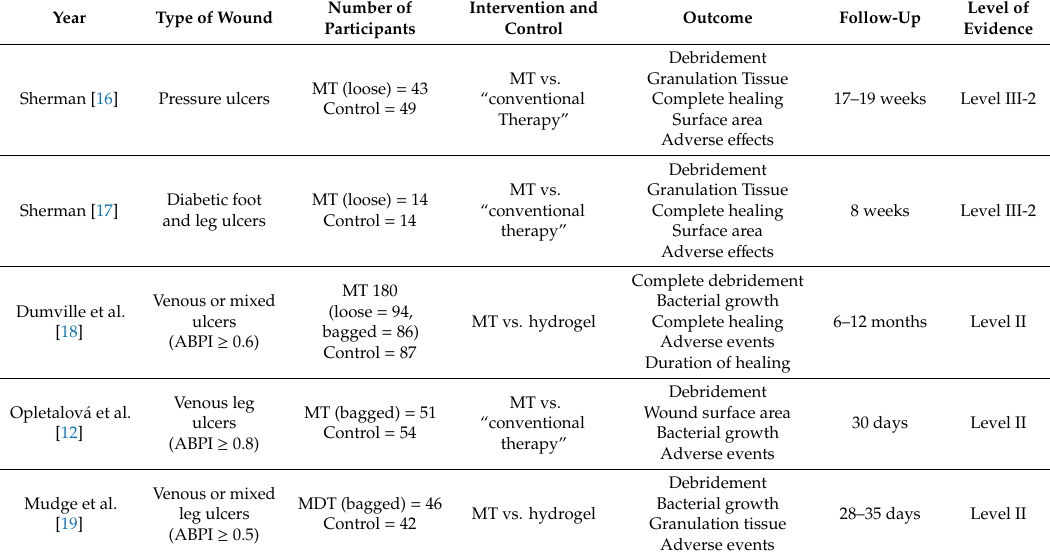
Table 1. Summary of included